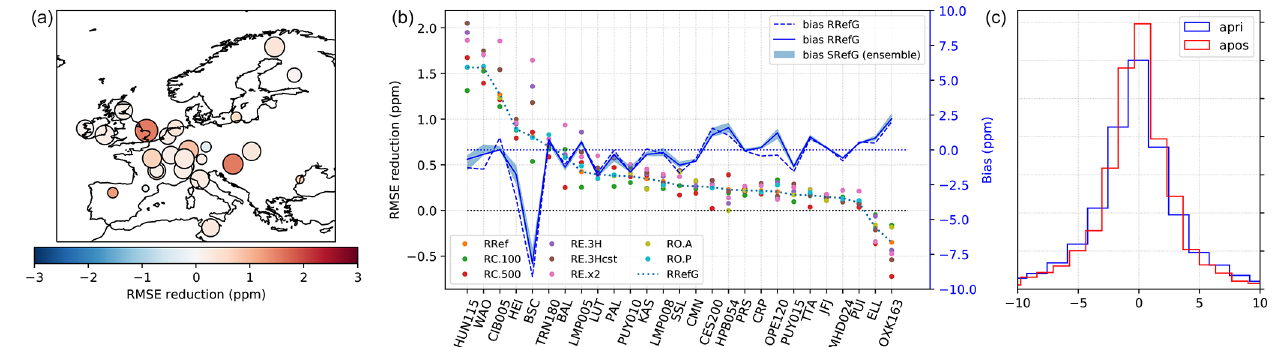
Figure 10. (a) Map of the observation sites in RRef, with the area of the dots proportional to the number of assimilated observations at each site and the color proportional to the RMSE reduction (prior RMSE minus posterior RMSE). (b) RMSE reduction at each site for the five sensitivity OSSEs, as well as prior (dashed blue line) and posterior (solid blue line) mean biases at each site (axis on the right). (c) Prior and posterior distribution of the observation mismatches in RRef (irrespective of the